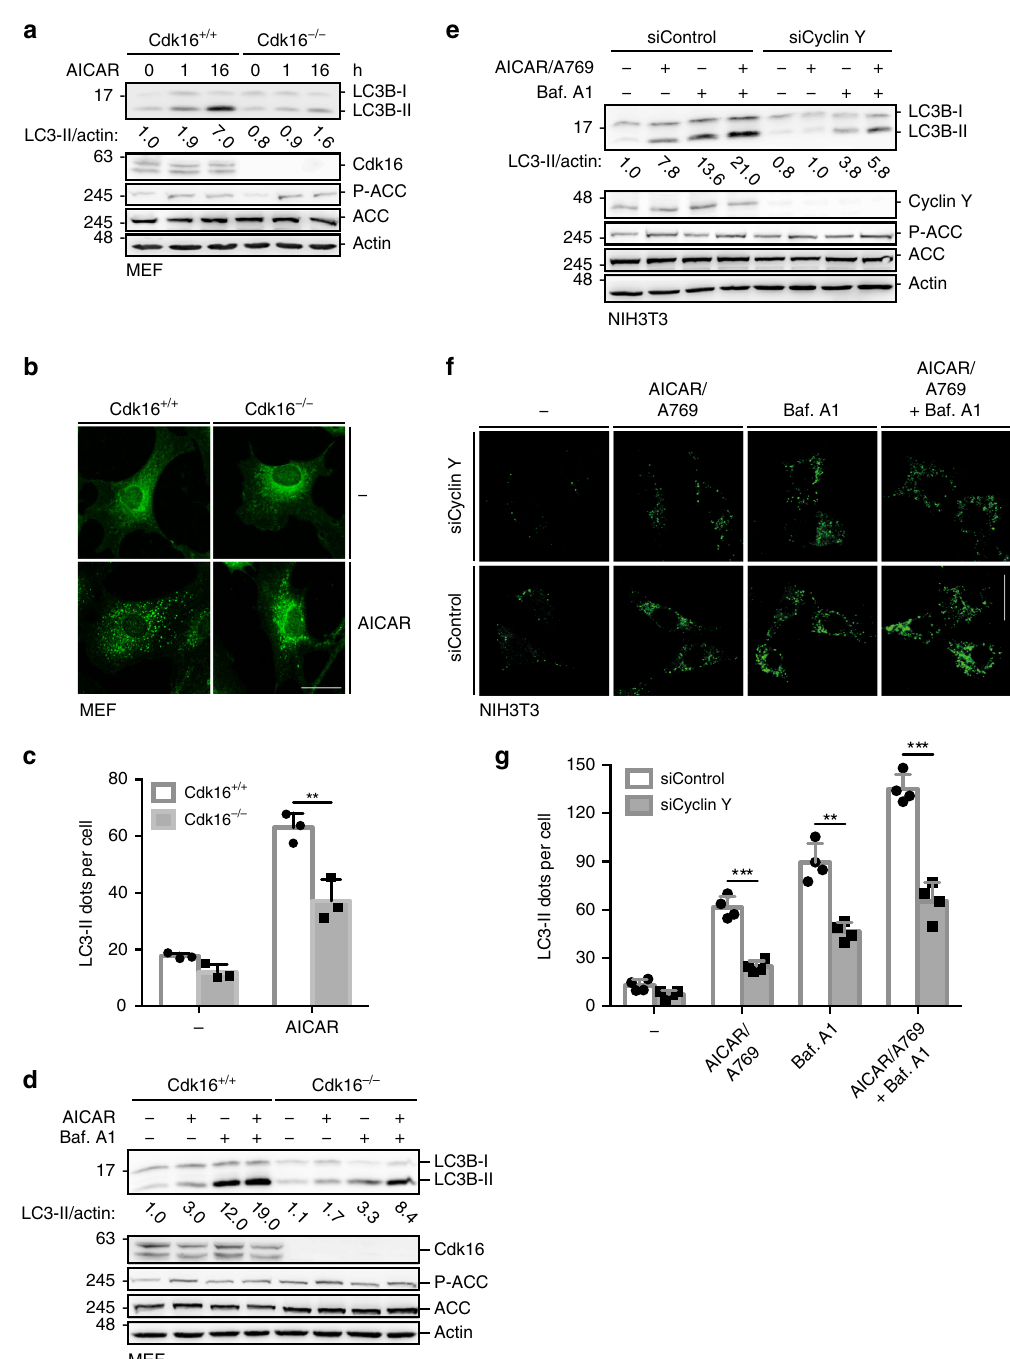
Fig. 6 AMPK-induced autophagy requires Cyclin Y/CDK16. a Immortalized Cdk16 + / + and Cdk16 − / − MEFs were treated with 1 mM AICAR for 1 or 16 h. Lysates were immunoblotted with the indicated antibodies ( n = 3). b Representative confocal images of the Cdk16 + / + and Cdk16 − / − MEFs treated as in panel a . Endogenous LC3 Staining with the 4E12 antibody monitored autophagy. Scale bar: 50 µ m. c LC3 dots of experiments as shown in panel b were quanti fi ed. Statistical signi fi cance was measured via unpaired and two-tailed Student ’ s t -tests and is presented as follows: ** p < 0.01. All error bars indicate SD. ( n = 3; 100 cells counted for each replicate; Cdk16 + / + + AICAR vs. Cdk16 − / − + AICAR: t = 4.964; df = 4). d Immortalized Cdk16 + / + and Cdk16 − / − MEFs were treated with 1 mM AICAR for 1 h and/or with 200 nM Ba fi lomycin A1 (Baf. A1) for 6 h as indicated. For the combination, AICAR was added during the last hour of Baf. A1 treatment. Lysates were immunoblotted with the indicated antibodies ( n = 1). e NIH3T3 cells were transfected with siRNA against Cyclin Y or control siRNA and stimulated with 0.5 mM AICAR/50 µ M A769662 (A769) or with 200 nM Baf. A1 or a combination. Proteins were analyzed as indicated. ( n = 3). f Representative confocal images of the NIH3T3 cells treated as in panel e . Endogenous LC3 was stained with the 4E12 antibody to depict autophagy. Scale bar: 50 µ m. g LC3 dots as shown in panel f were quanti fi ed. Statistical signi fi cance was measured via unpaired and two- tailed Student ’ s t -tests and is presented as follows: ** p < 0.01, *** p < 0.001. All error bars indicate SD. ( n = 3; 100 cells counted for each replicate; AICAR/ A769: t = 9.494, df = 6; Baf. A1: t = 6.549, df = 6; AICAR/A769 + Baf. A1: t = 9.484, df = 4). n biological independent replicate. SD standard deviation. Source data are provided as a Source Data fi